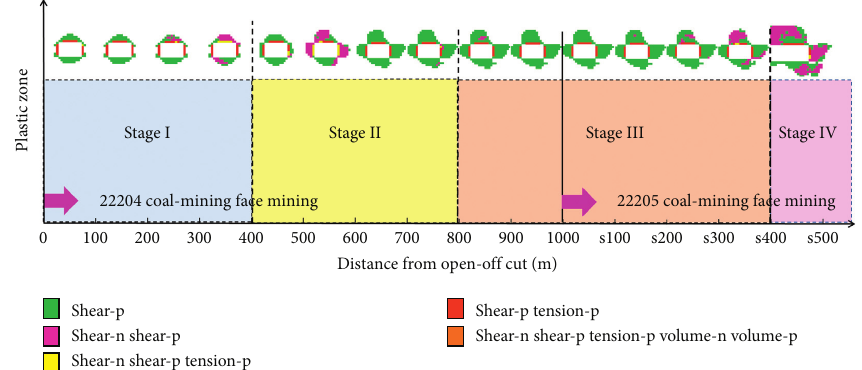
Figure 10: Stage change diagram of plastic zone in reserved roadway 500m from the open-off cut.